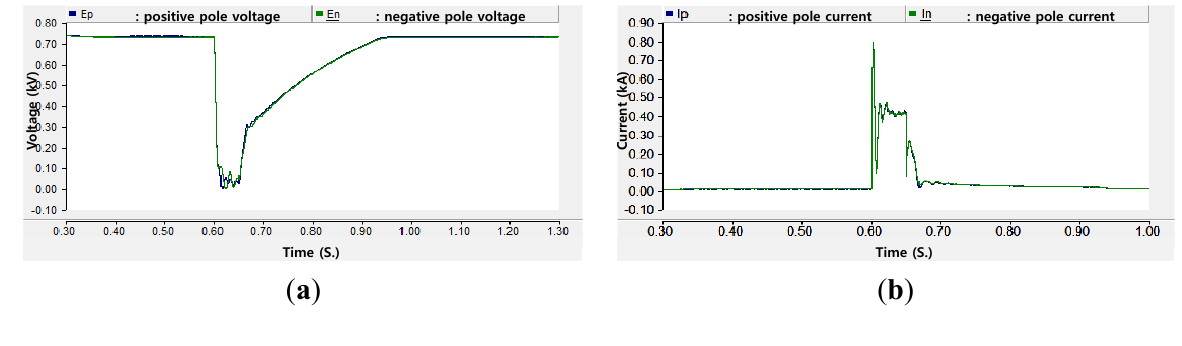
Figure 8. Resulting waveforms of O/H line: ( a ) voltage and ( b )